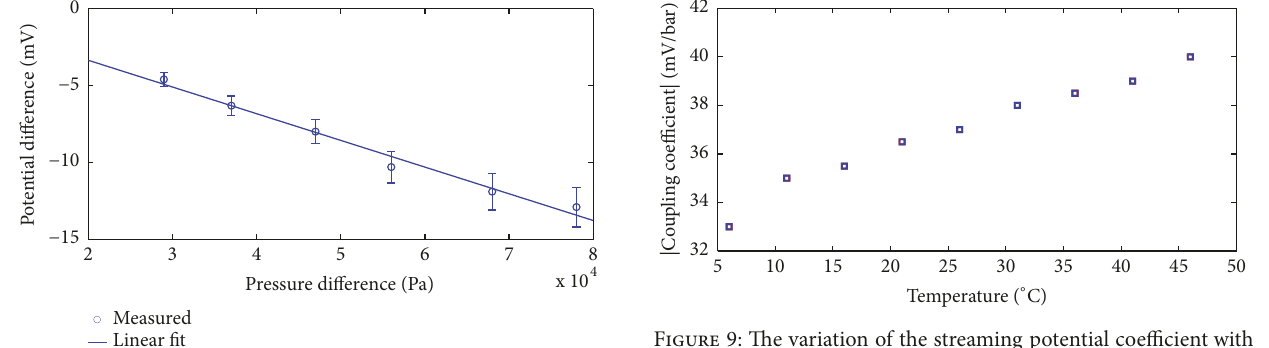
Figure 9: The variation of the streaming potential coefficient with temperature for NaCl electrolyte only at 5.10 −3 M obtained from [35].